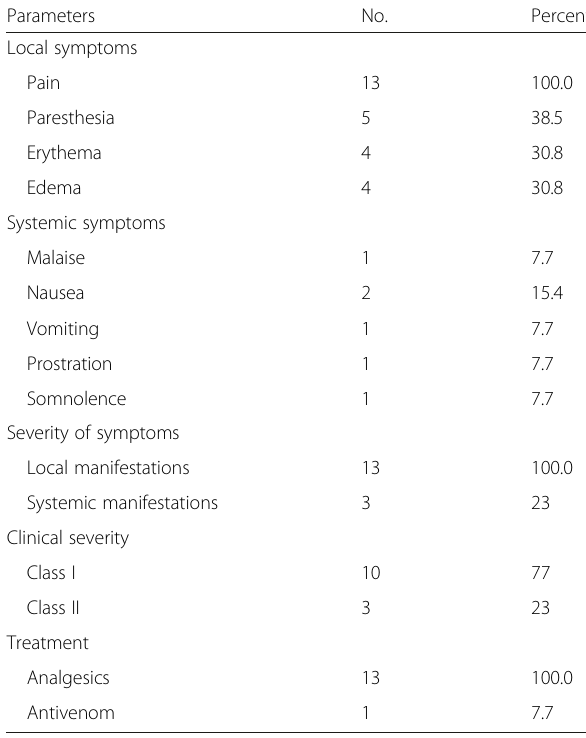
Table 1 Circumstances of scorpionism by T. silvestris in Pará state, eastern Amazon, Brazil